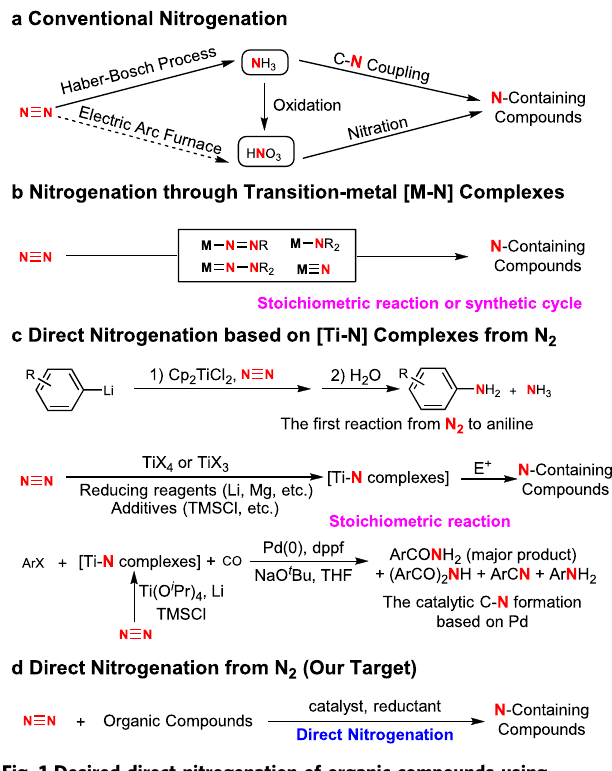
Fig. 1 Desired direct nitrogenation of organic compounds using dinitrogen (N 2 ). a Traditional nitrogenation procedures using NH 3 and HNO 3 as platform chemicals. b Production of N-containing organic compounds from dinitrogen using M – N complexes in stoichiometric reactions. c Incorporation of N 2 into organic compounds with stoichiometric Ti – N complexes as intermediates. d Desired catalytic nitrogenation using N 2